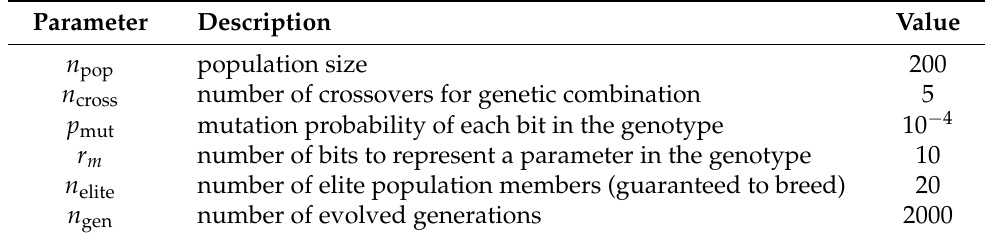
Table 1. Overview of parameters of the genetic algorithm.